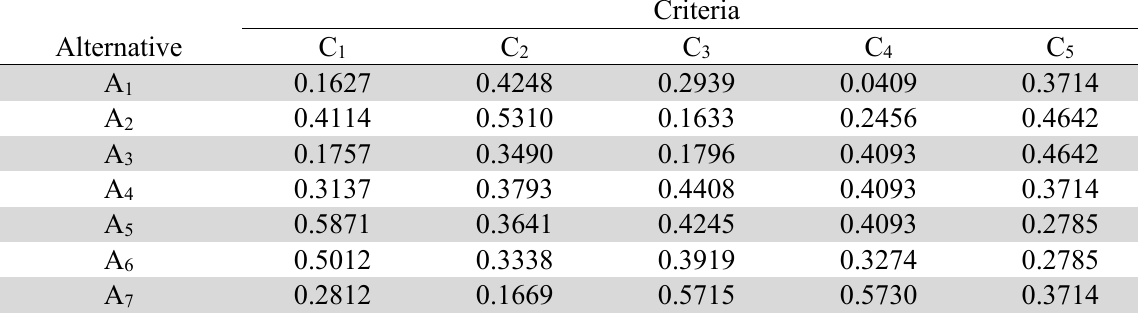
Normalized decision matrix for neat oil selection problem